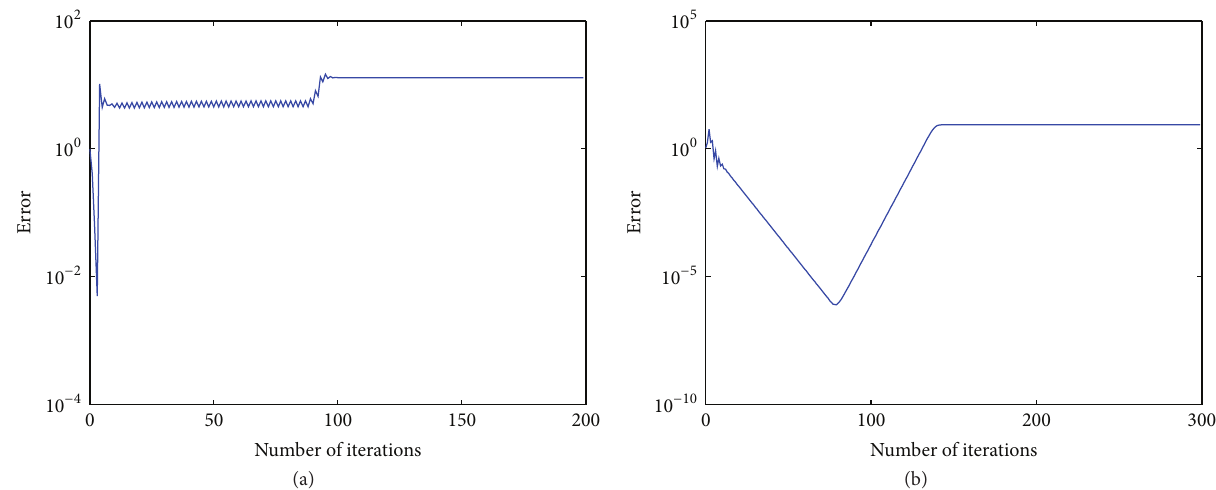
Figure 2: Convergence analysis for lattice soliton corresponding to the first renormalization factor with 𝜇 = 1.29 ; (b) convergence analysis for lattice soliton corresponding to the second renormalization factor with 𝜇 = 1.49 .